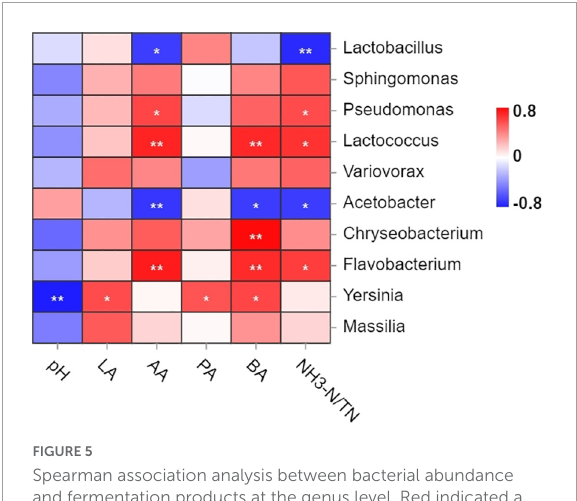
FIGURE5 Spearman association analysis between bacterial abundance and fermentation products at the genus level. Red indicated a positive correlation, and blue indicated a negative correlation. LA, lactic acid; AA, acetic acid; PA, propionic acid; BA, butyric acid; NH 3 -N/TN, ammonium nitrogen/total nitrogen. * P < 0.05; ** P <